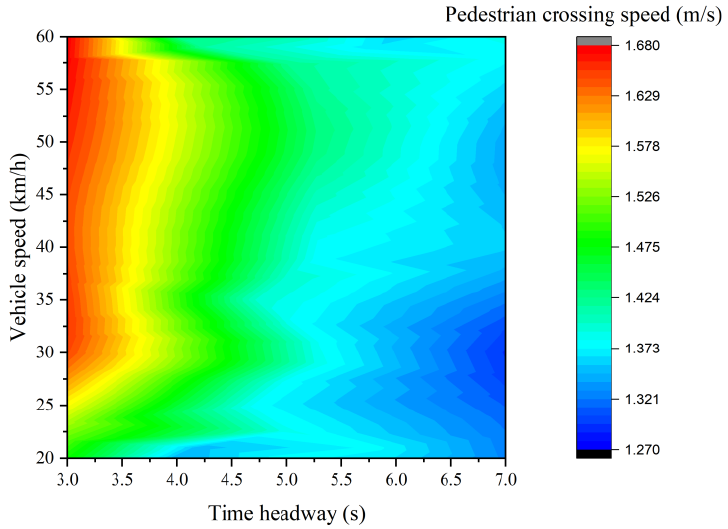
Figure 4. Variation in pedestrian crossing speed with vehicle time headway and vehicle speed. Table 4. Analysis result of the partial correlation between time headway and pedestrian crossing speed. Pedestrian Crossing Control Variable Variable Time Headway Speed Time headway Vehicle speed